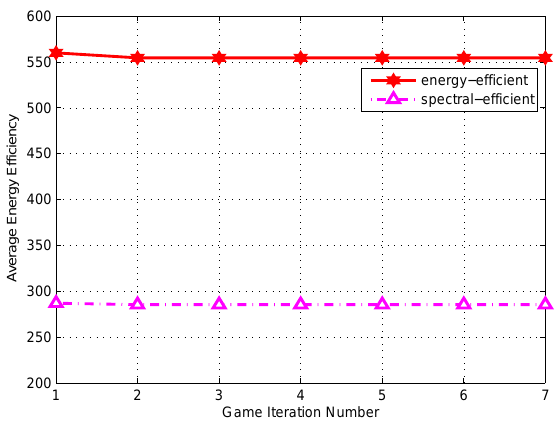
Figure 2: The locations of D2D UEs and cellular UEs generated in one simulation ( N = 20 , K = 10 , the cell radius is 500 m, and maximum D2D distance is 25 m ).